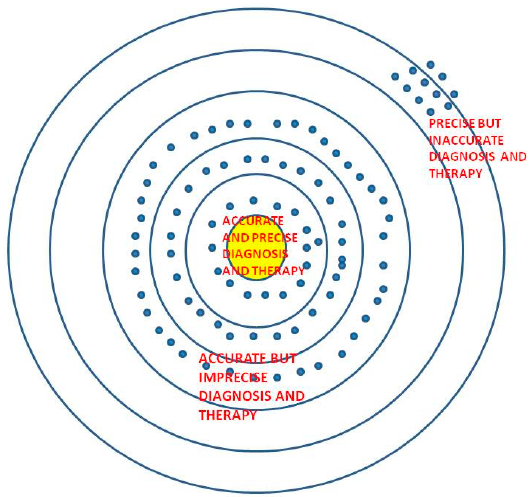
Figure 1. Mapping ‘Precision’ and ‘Accuracy’ in Medicine (Accuracy—achieving patients’ requirement of best outcome, and Precision—the narrowest path to achieve it).